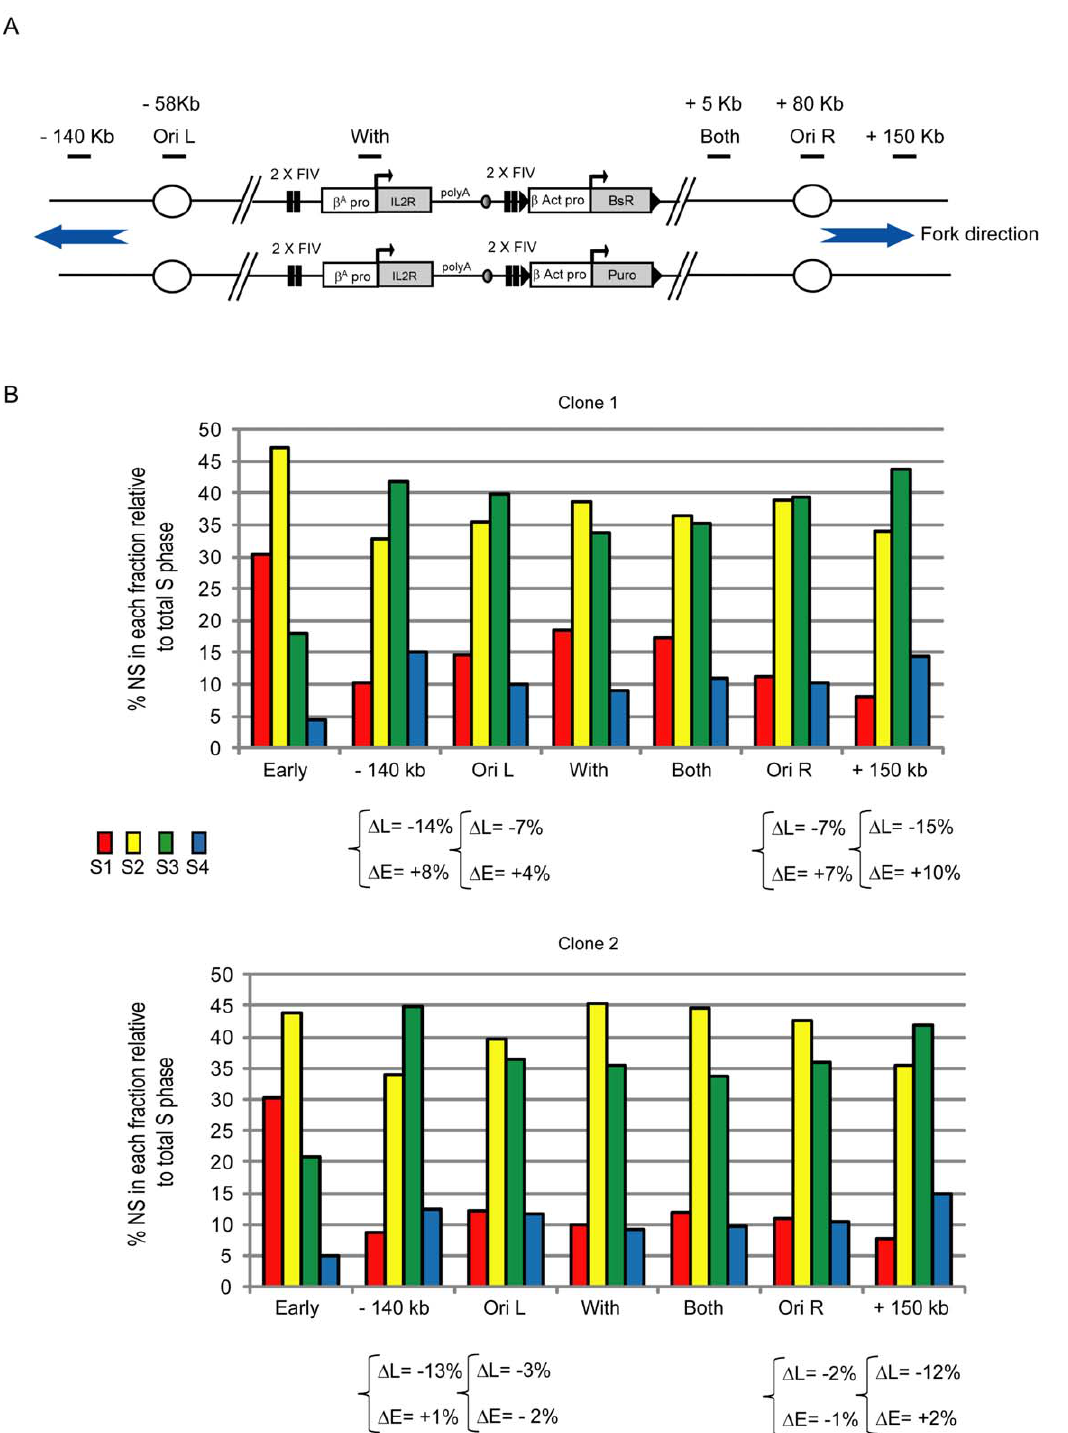
Figure 9. The replication timing shift affects only the replicon located inside the transgene. Replication timing profiles surrounding DT40 chromosomal alleles following transgene integration into both alleles. (A) Schematic representation of the transgenic locus containing the IL-2R transgene flanked by two copies of the FIV USF binding site linked to the b -actin blasticidin resistance transgene on one allele and puromycin resistance transgene on the other. Primer pairs used are located at the top of the figure, and their positions relative to the site of insertion are indicated. The global replication forks’ directions deduced from panel B are shown. (B) Analysis of replication timing at the integration site and over a , 300 kb region surrounding the transgene integration site in two clonal cell lines. The differences in late or early replication ( D L and D E) at flanking regions compared with the integration site (With) are shown.